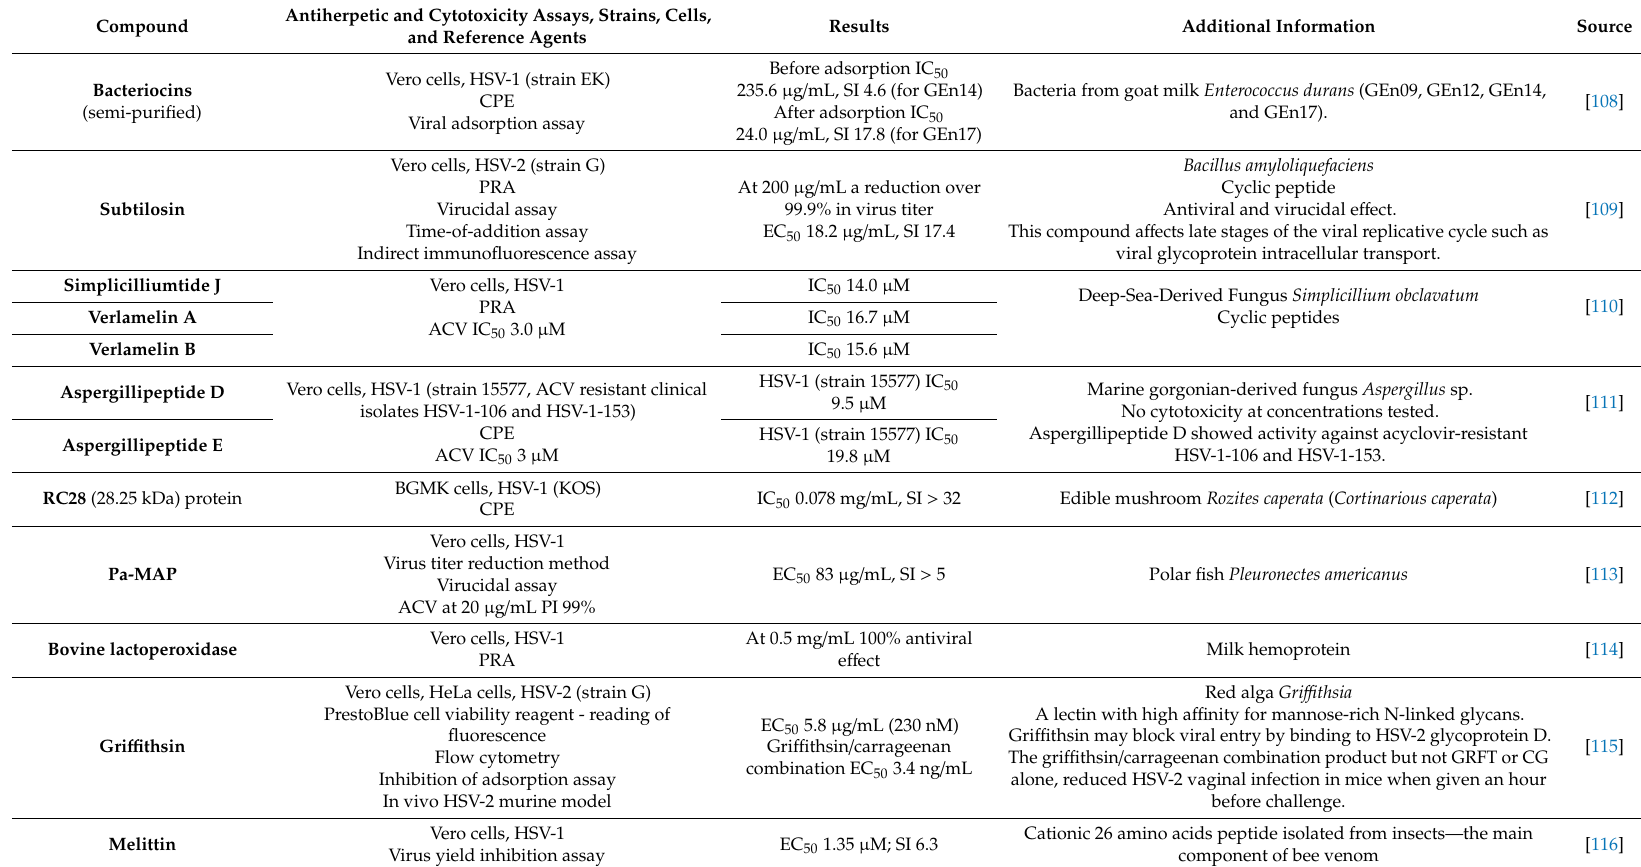
Table 6. The overview of peptides with anti-HSV